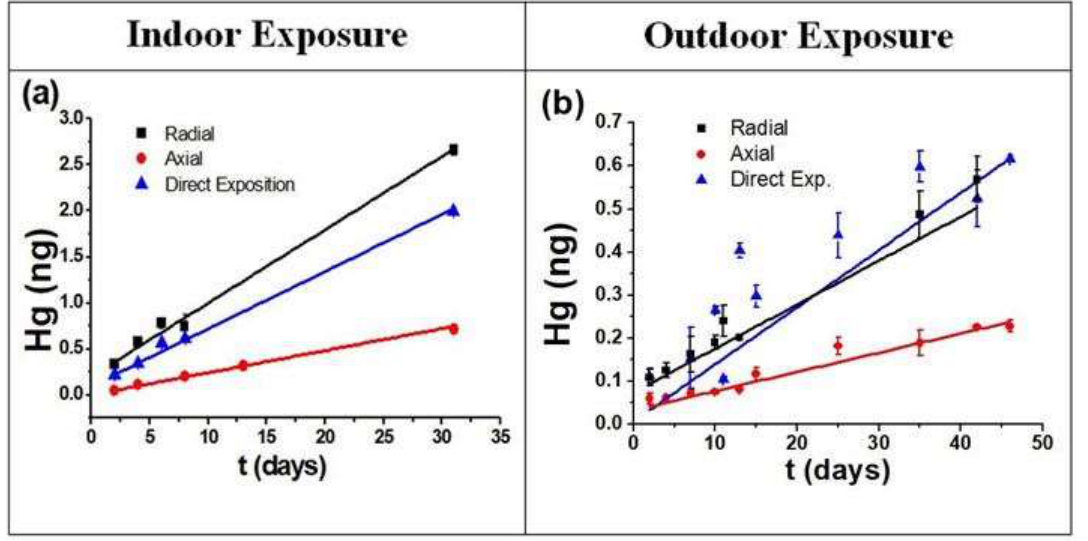
Figure 5. Adsorbed TGM on samples exposed indoors ( a ) and outdoors ( b ).